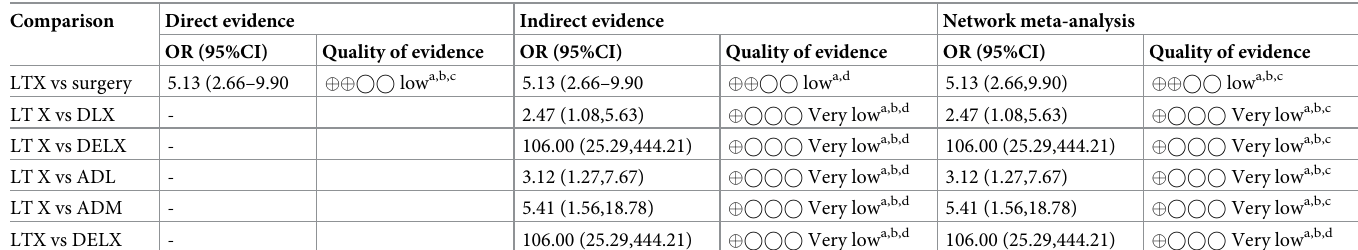
Table 4. GRADE quality of evidence for the comparative R0 resection